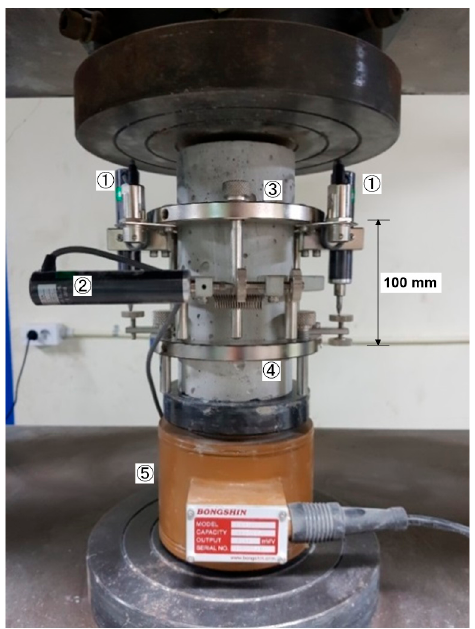
Figure 7. Test setup for the uniaxial compressive test for measurements of compressive strength, static elastic modulus and static Poisson’s ratio of concrete cylinders: ① extensometers for measuring longitudinal deformation; ② an extensometer for measuring transverse deformation; ③ and ④ upper and lower fixed aluminum ring for installing extensometers, respectively; and ⑤ load cell.